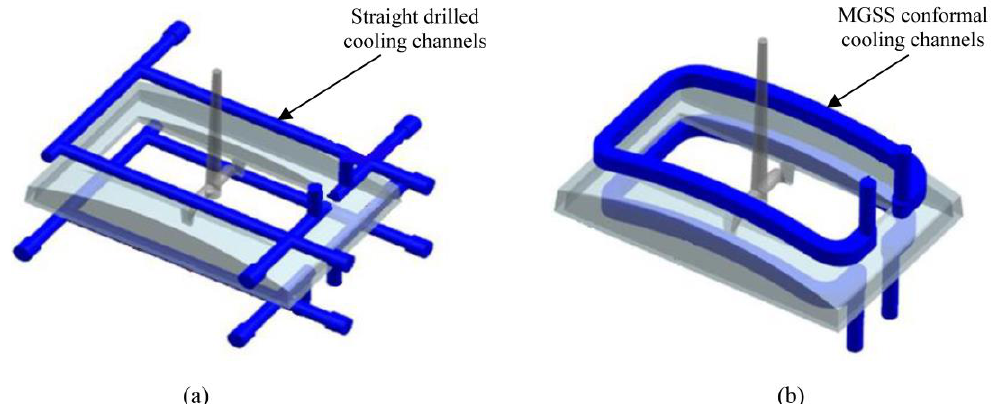
Figure 3. Front panel housing, ( a ) with straight drilled cooling channels, ( b ) with Milled Groove Square Shape (MGSS) conformal. cooling channels.